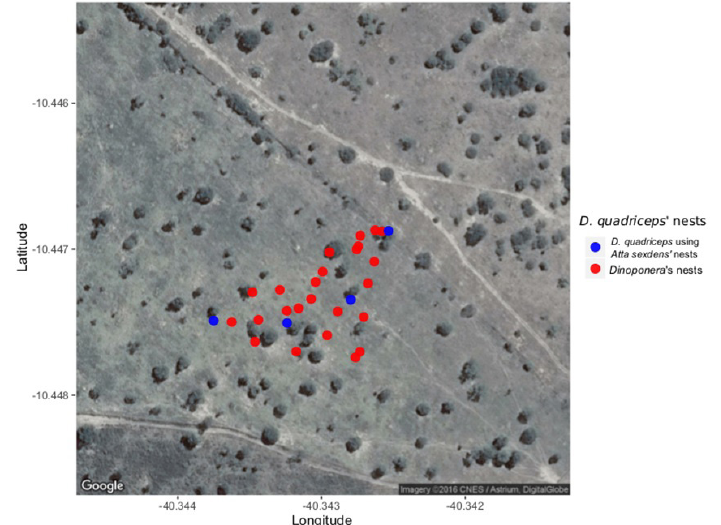
Fig 1 . Sampled nests, in blue nests of Atta sexdens used by Dinoponera quadriceps .